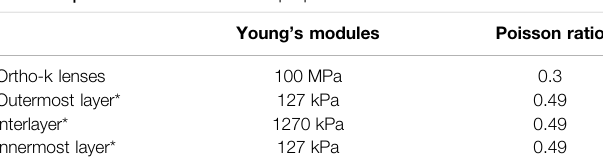
TABLE 3 | Lens and cornea material